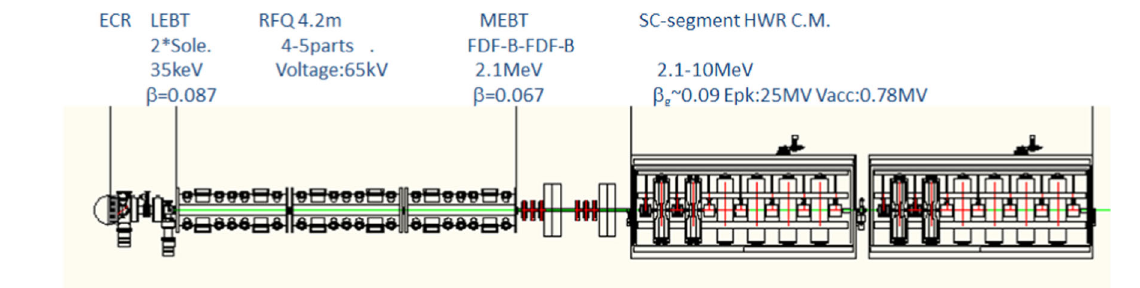
FIG. 2. Layout of the C-ADS injector scheme